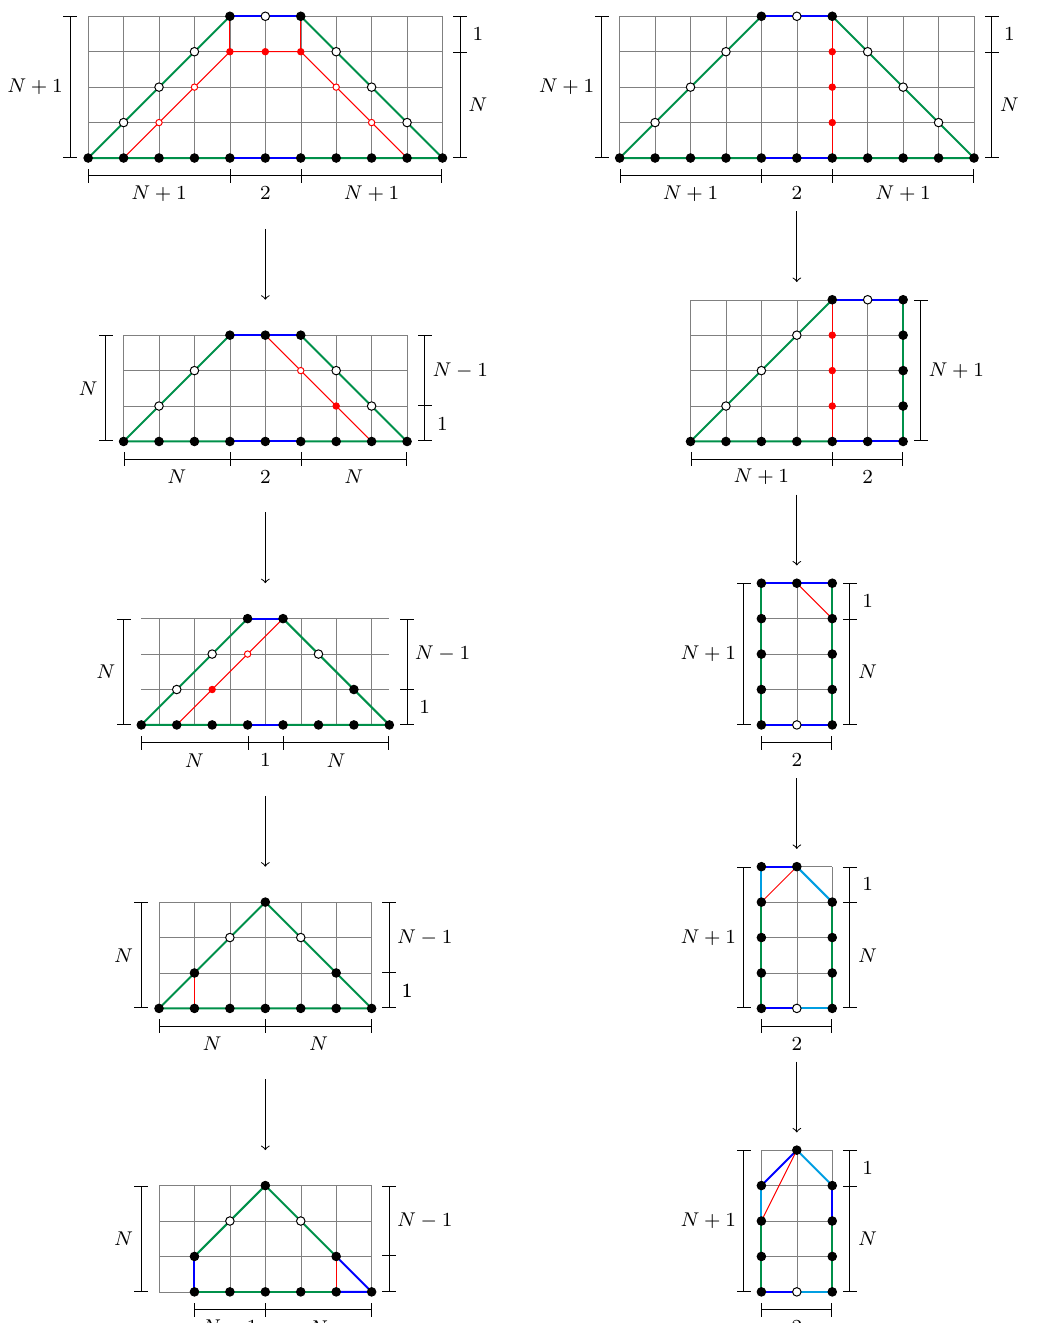
Figure 6. The GTP decoupling trees for SU( N ) SU( N ) with 2 N + 3 − k flavors (on the right), drawn for N = 3 , corresponding to the FI k − 1 2 deformations shown in figure